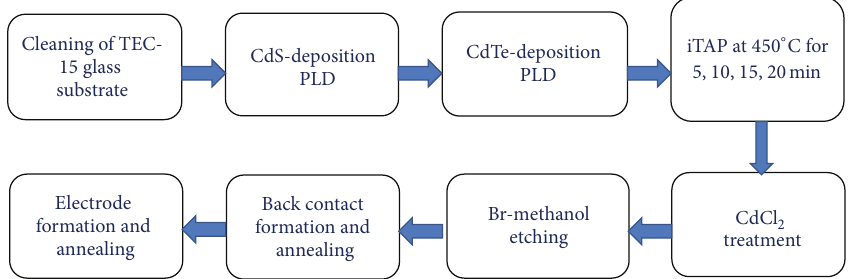
Figure 1: Schematic description of the key steps in CdS/CdTe solar cell fabrication including PLD deposition of CdS/CdTe heterostructures, followed with iTAP and